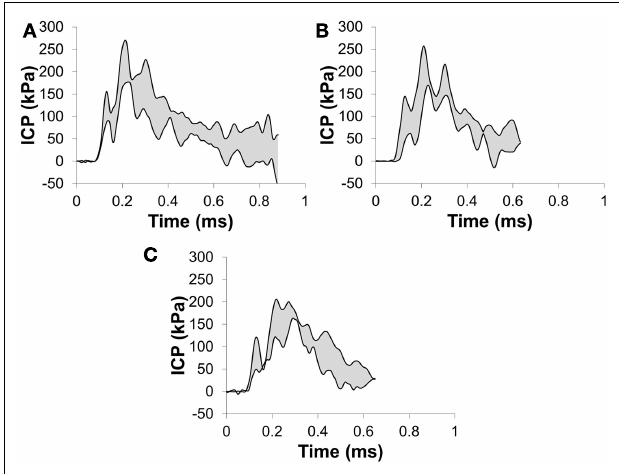
FIGURE 8 | Corridors for the pressure in (A) the right parietal lobe, (B) the frontal lobe, and (C) the left parietal lobe for a 273-kPa peak overpressure with a 6.4-ms positive phase duration incident shock wave.